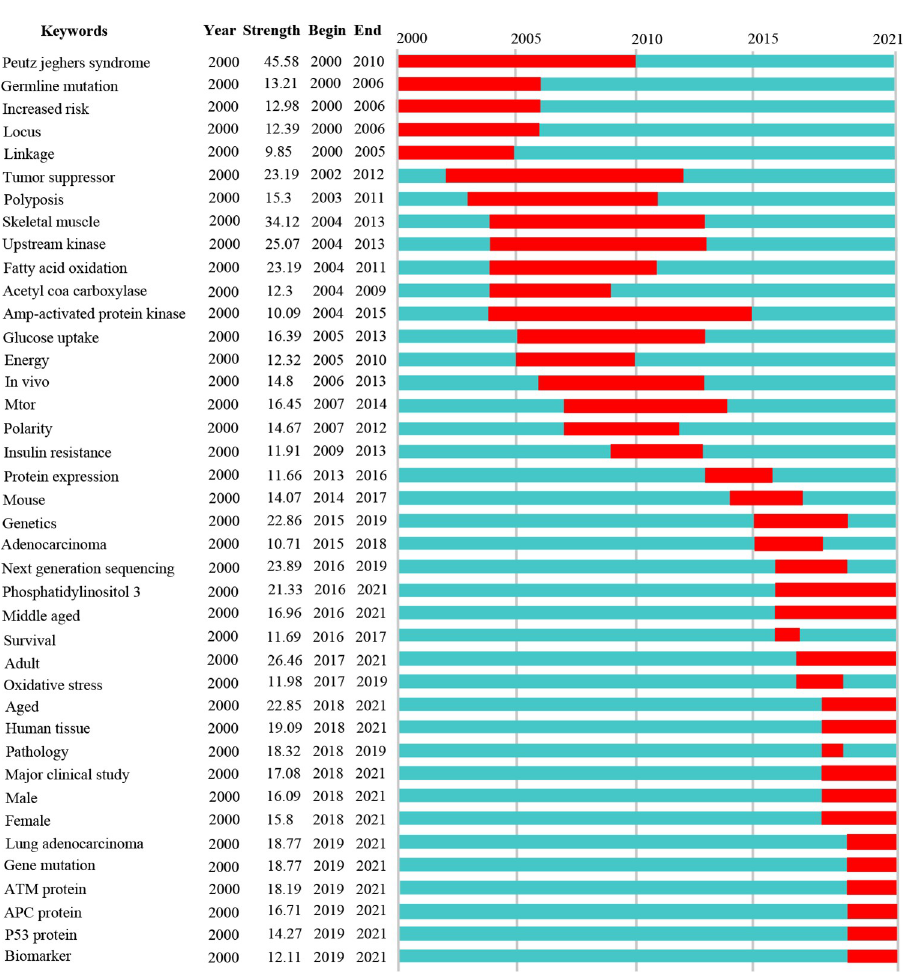
Fig 9. The top 40 strongest citation burst keywords in LKB1 research during 2000–2021. The green bar represents the time interval from 2000 to 2021, and the red bar represents the burst cited time of keyword. “Year” column represents the earliest year in which the keyword had been published in the field of LKB1 research, “Begin” and “End” columns represent the begin and end years between which the keyword had been burst cited, and “Strength” column represents the strength with which the keyword had been burst